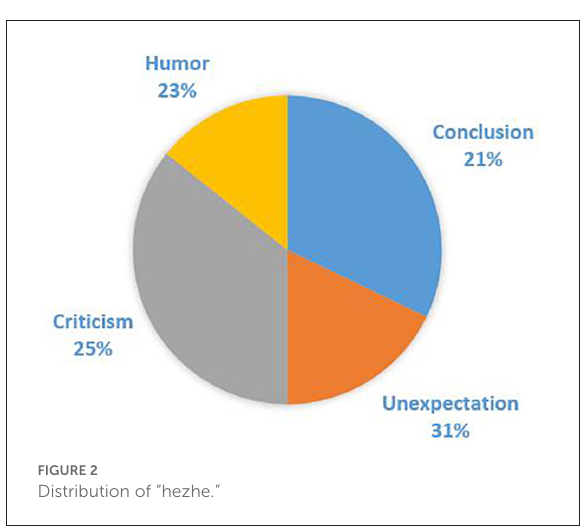
FIGURE2 Distribution of